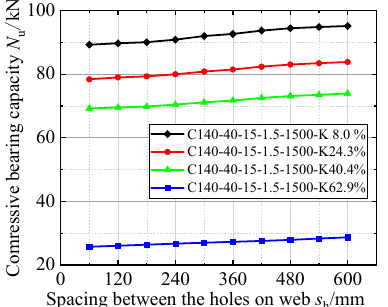
Figure 20. N u -S h relationship of combined columns. Figure 20. N u - S h relationship of combined